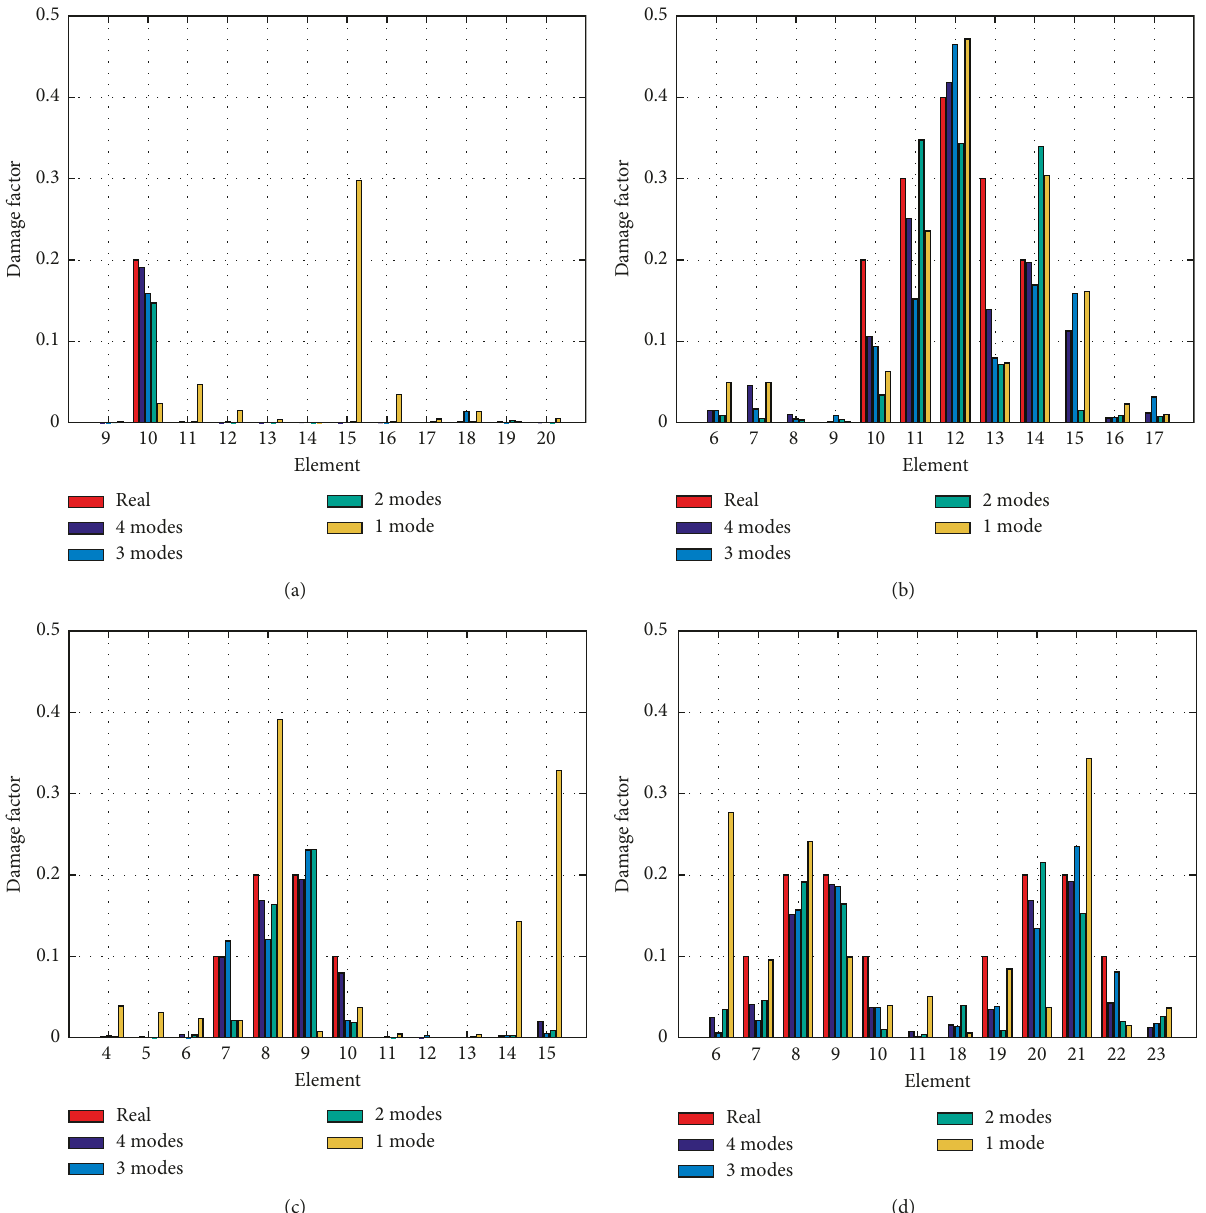
Figure 18: Frame example: performance of the combined criterion for different damage scenarios (noise 10%). (a) Scenario 1, (b) scenario 2, (c) scenario 3, and (d) scenario 4. Table 5: Frame example: norm values for the combined criterion and different damage scenarios (three known eigenmodes). Criterion